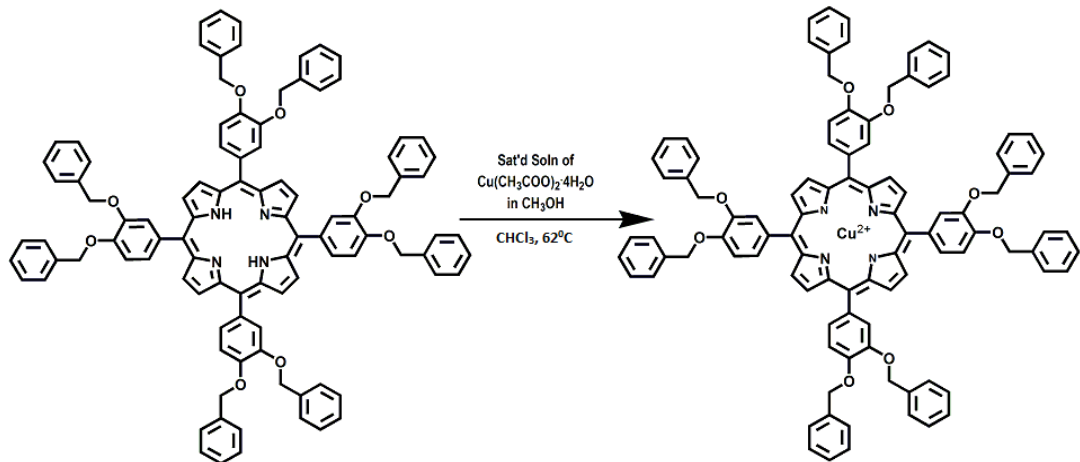
Figure 1. Synthesis of Copper 5,10,15,20-Tetrakis-(3,4-dibenzyloxyphenyl)porphyrin.